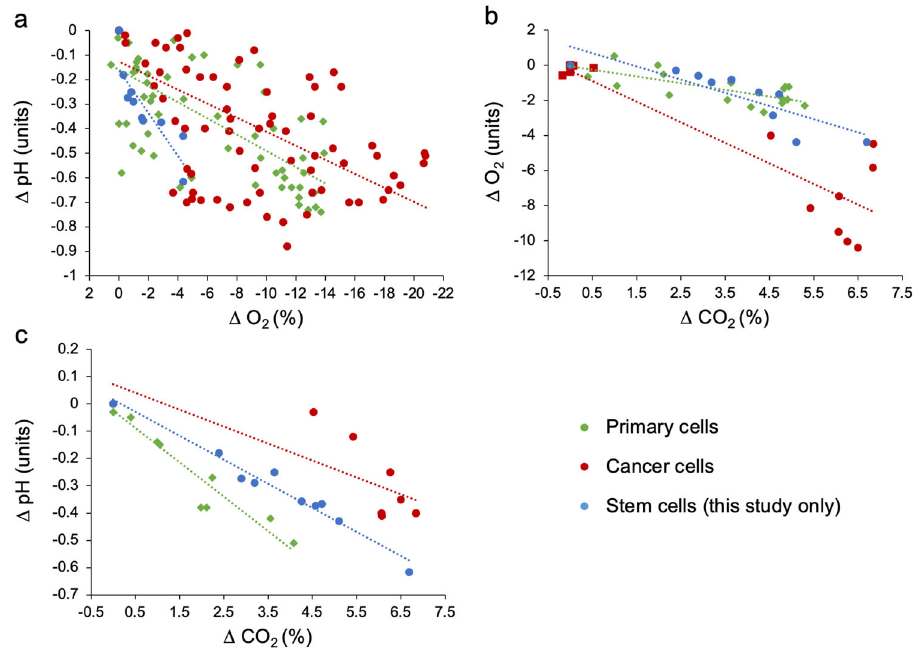
Fig. 6 Relationships between changes in dissolved gases and medium acidi fi cation in mammalian cell cultures. Delta ( Δ ) values for pH, dO 2 , and dCO 2 represent the mean difference between levels measured at various time points during culture minus measurements taken at time zero (cf. Supplementary Figs. S3 and S4). a The relationship between reductions in pH and increases in dO 2 in cell culture media. b The relationship between reductions in dO 2 and increases in dCO 2 in cell culture media. c The relationship between reductions in pH and dCO 2 in cell culture media. Data points represent a combination of mean Δ values extracted from six published studies (examining nine cell lines) and mean Δ values obtained from this study. Insets show the Pearson correlation coef fi cient ( r ) and p -value for each correlation model (Supplementary Table S3). Cell lines were categorized as belonging to one of three main categories (primary cells, cancer cells, or stem cells, cf. data availability section for full